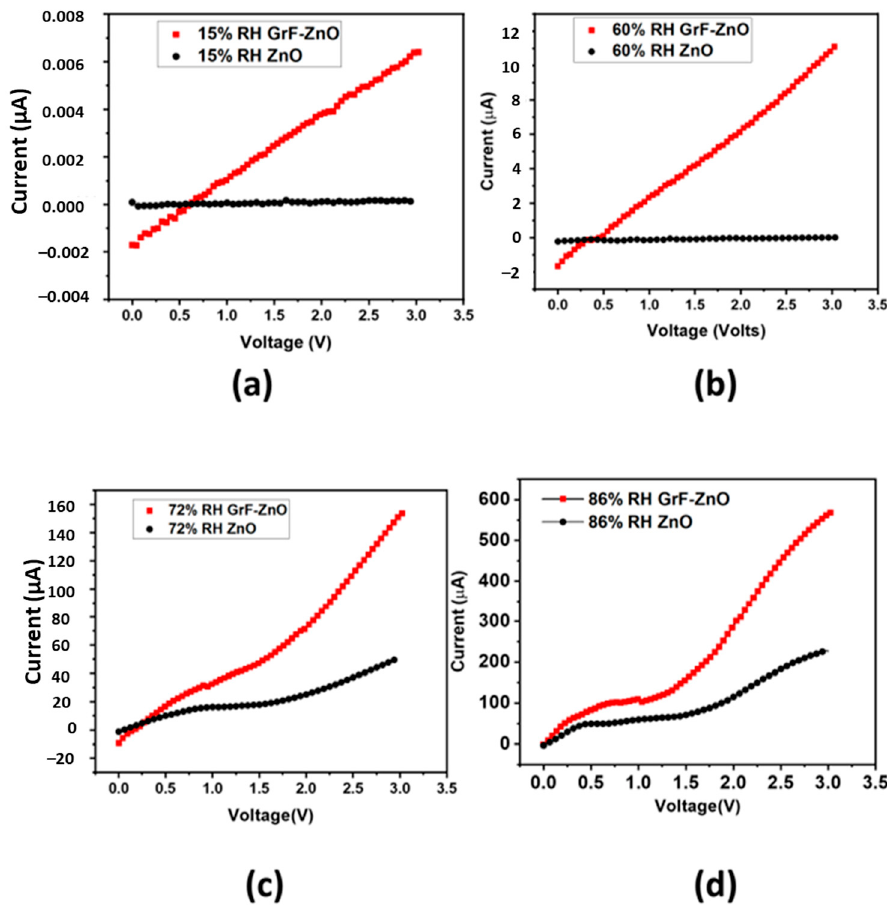
Figure 8. Current vs. voltage at different RH%, ( a ) 15% RH; ( b ) 60% RH, ( c ) 72% RH and ( d ) 86%